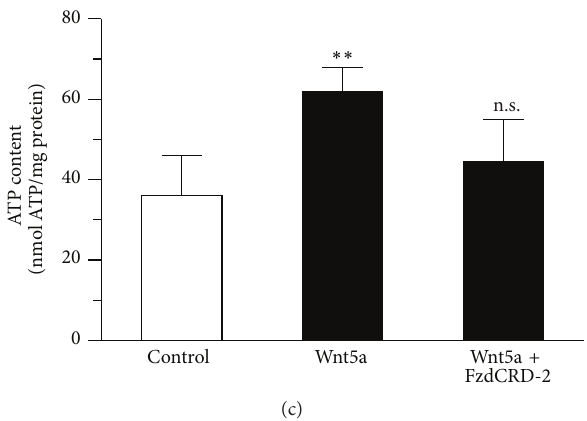
Figure 2: The activation ofnoncanonical Wnt pathways stimulatestheglycolytic ratein cortical neurons. (a)Treatment with Wnt5a stimulates the HK activity in a time-dependent manner (i), and this effect was blocked by coincubation with FzdCRD-2 and 7NI (ii). (b) Incubation with Wnt5a stimulates the glycolytic rate (i); this effect was blocked by coincubation with 7NI and FzCDR-2 and stimulated in a concentration- dependent manner by the NO donor SNP ((ii) and (iii)). (c) Treatment with Wnt5a by 2 h increases ATP production; this effect was blocked by the coincubation with FzdCRD-2. Data represent the mean ± SEM of 𝑛 = 6 , each performed in triplicate. ∗ 𝑝 < 0.01 ; ∗∗ 𝑝 < 0.005 , Bonferroni